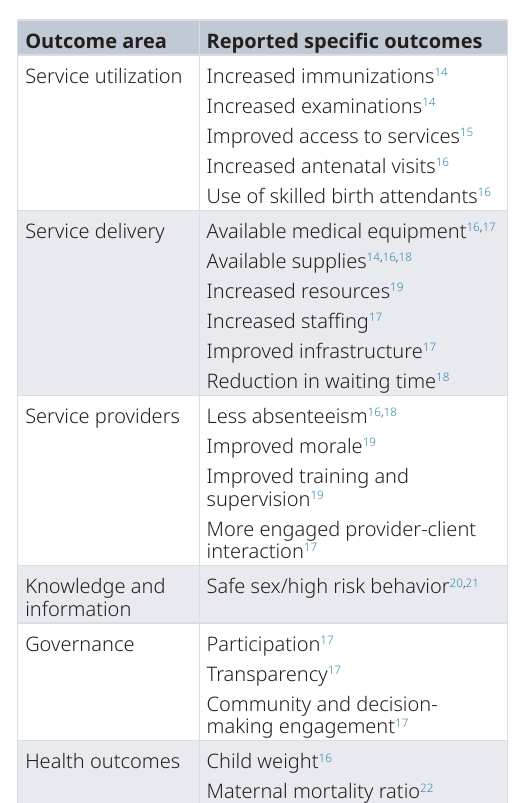
Table 1. Examples of reported outcomes from studies of social accountability in reproductive, maternal, newborn, child and adolescent health